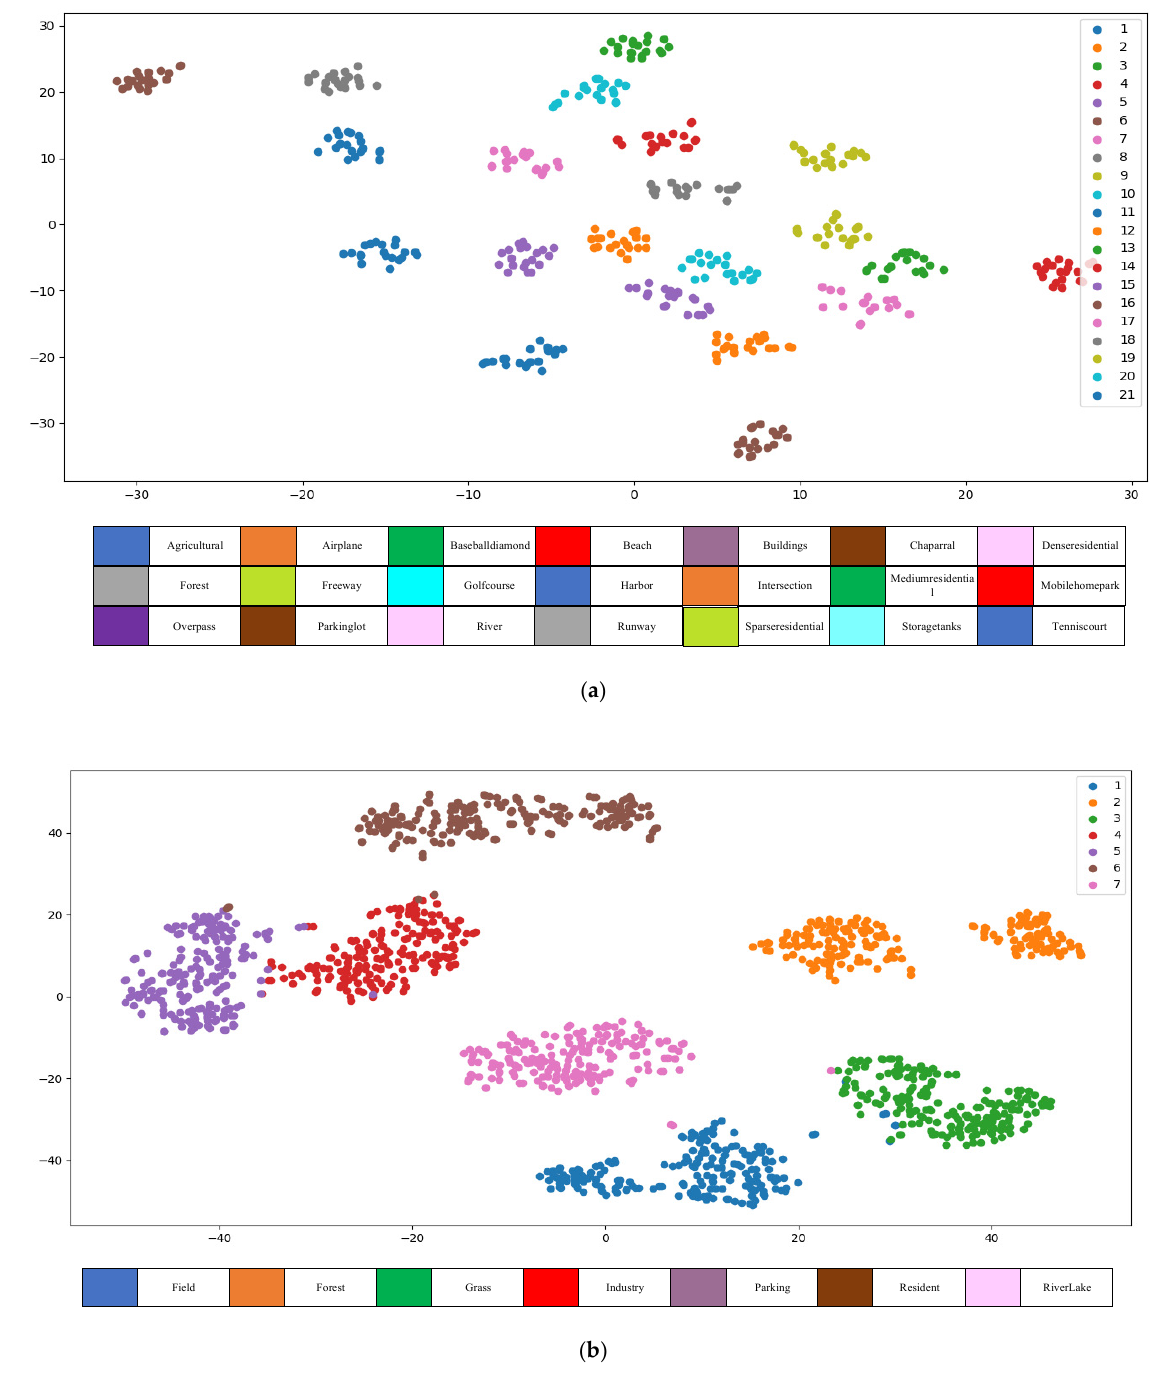
Figure 8. T-SNE visualization results on 80/20 UC and RSSCN (50/50) datasets. ( a ) T-SNE visualization results on 80/20 UC datasets. ( b ) T-SNE visualization results on 50/50 RSSCN datasets.